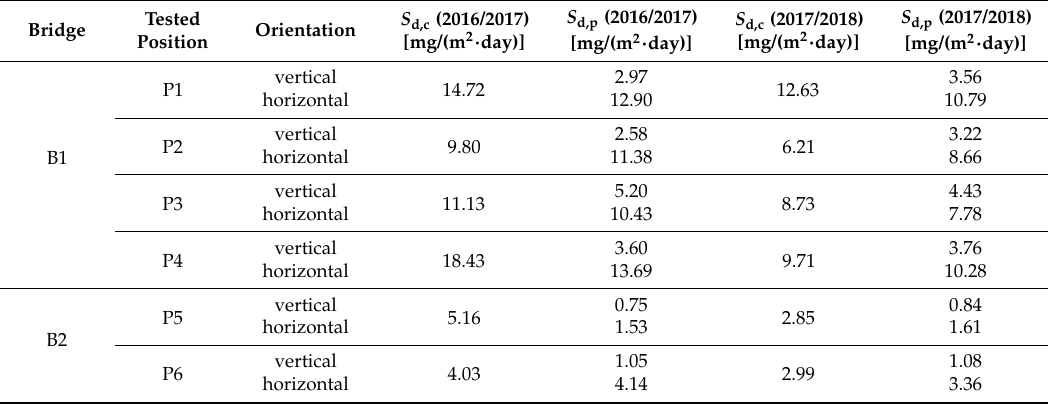
Figure 11. Deposition rates of chlorides determined by the dry plate method (vertical position). Table 2. Average annual deposition rates of chlorides for the two measured seasons and individual methods of measurement [mg/(m 2 · day)].